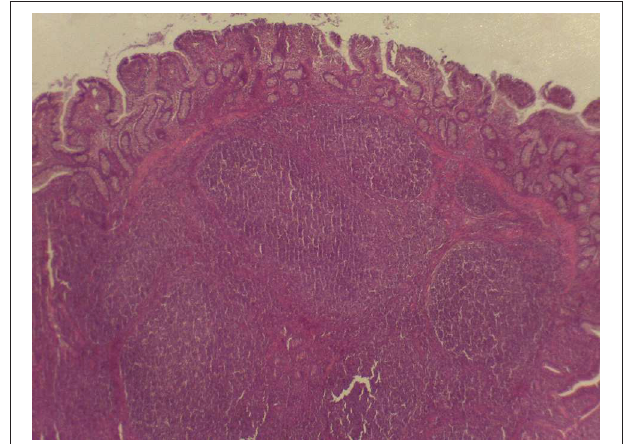
FIGURE 5 | Microscopy of PPs in pigs from the experimental group fed with the CP diet.